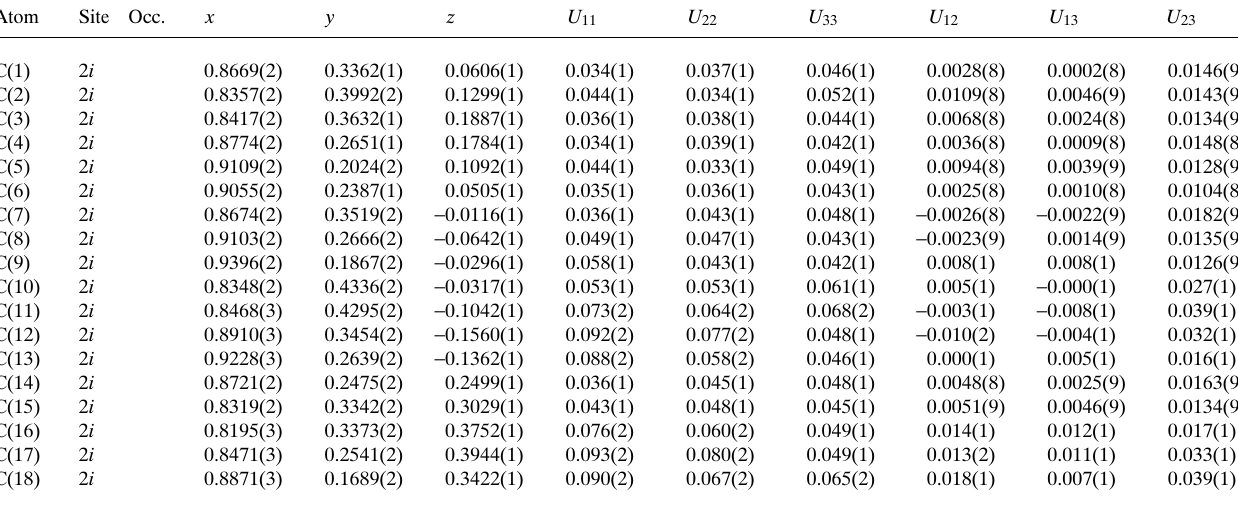
Table 3. Atomic coordinates and displacement parameters (in Å 2 ) .